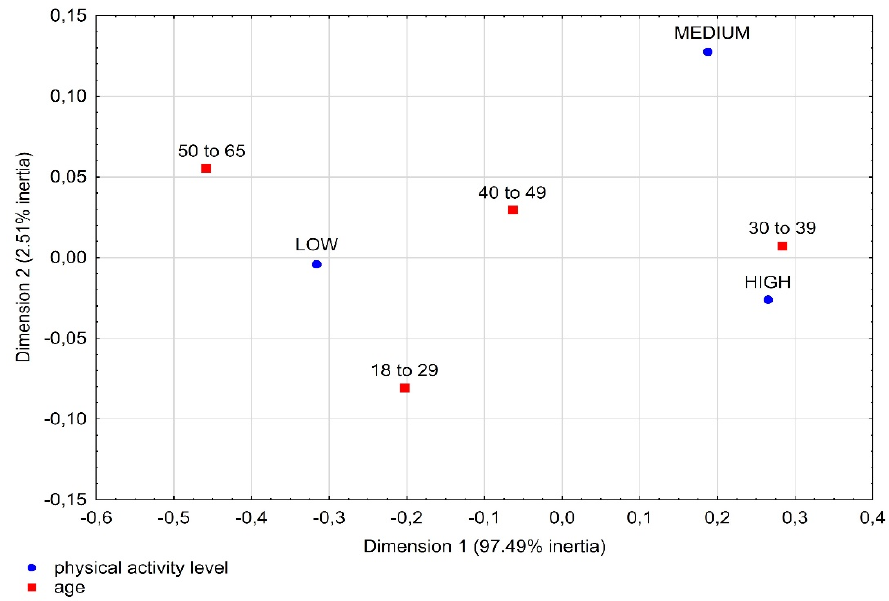
Figure 1. A biplot of the first two axes of correspondence analysis illustrating various physical activity levels and how they relate to specific age groups.